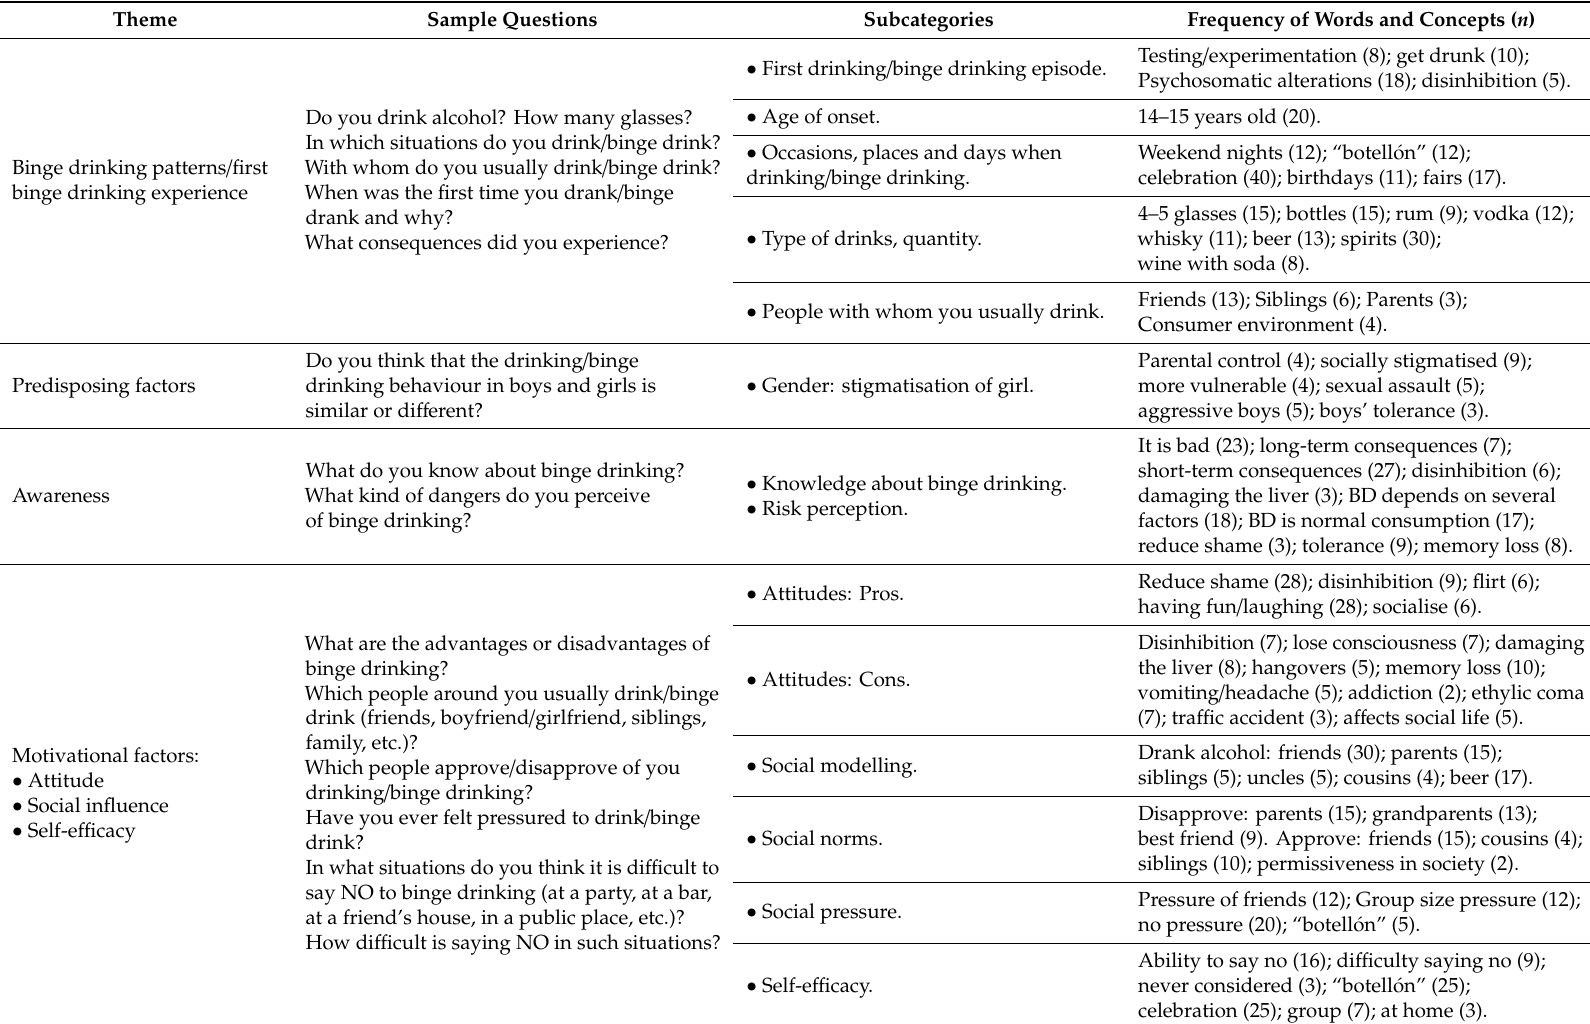
Table 2. Themes, subcategories, frequency of words and concepts, and sample questions for the adolescent FG